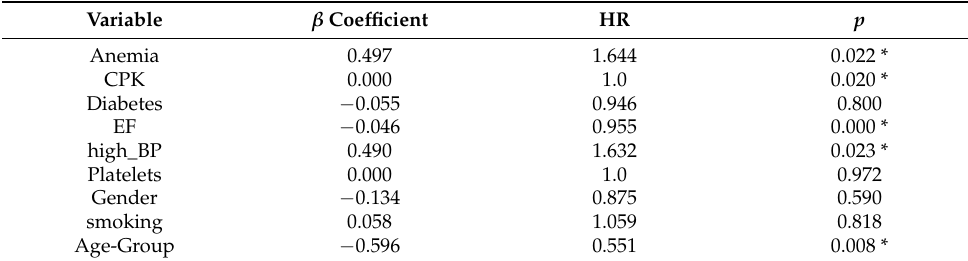
Table 12. Significance Check towards Survival-Status.